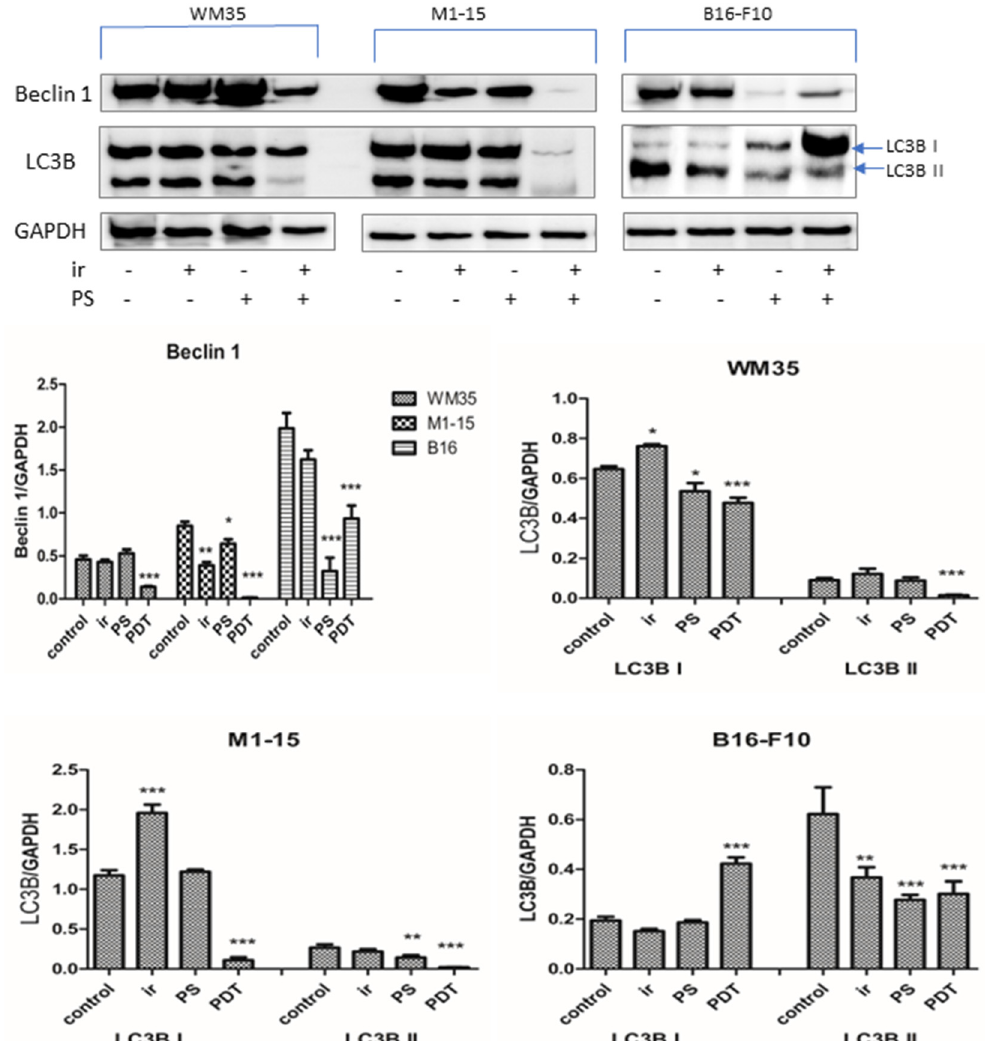
Figure 9. Autophagy. Expression of LC3B I and II and beclin 1. 1 = control, 2 = irradiated (100 mJ/cm 2 ), 3 = THPP (15 µ g/mL), 4 = PDT (THPP 15 µ g/mL and irradiation 100 mJ/cm 2 ). Graphical representation of quantitative WB results. Each bar represents mean ± SD ( n = 3). * = p < 5.0 × 10 − 2 , ** = p < 1.0 × 10 − 2 , *** = p < 1.0 × 10 − 3 , compared to control.